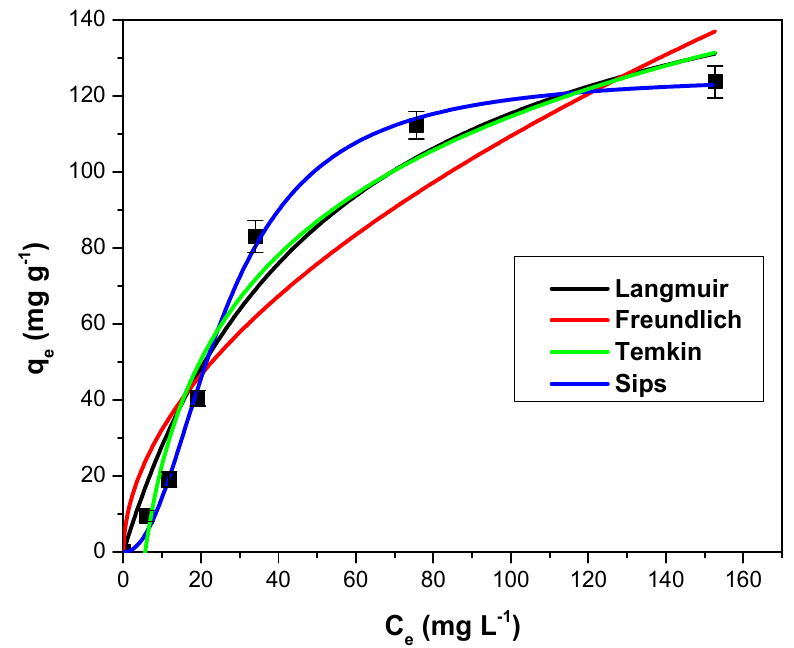
Figure 5. The experimental data and the fitted isotherm curves for crystal violet adsorption on adsorbents obtained from motherwort biomass. Table 1. The tested isotherms models’ constants and the corresponding statistical parameters.